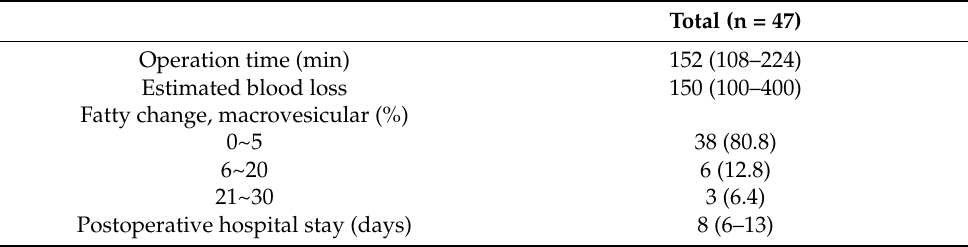
Table 4. Operative outcomes of donors that underwent